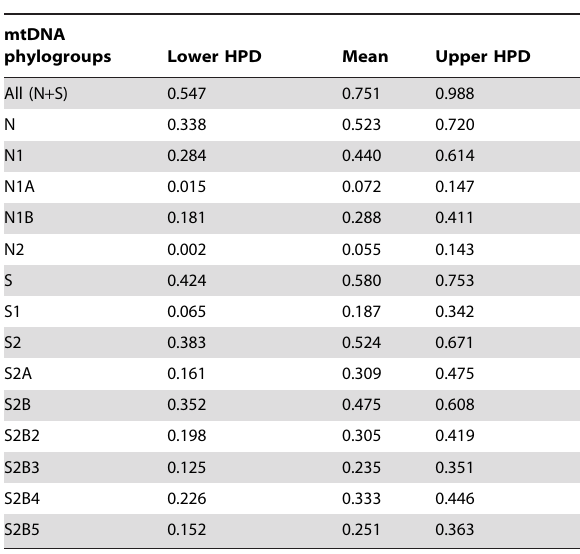
Table 2. Divergence time estimates in million years (Ma) from the most recent common ancestor (mrca) of all phylogroups of L. pictus recovered in the phylogenetic analysis using Beast. Codes of mtDNA phylogroups as in tree in Fig.